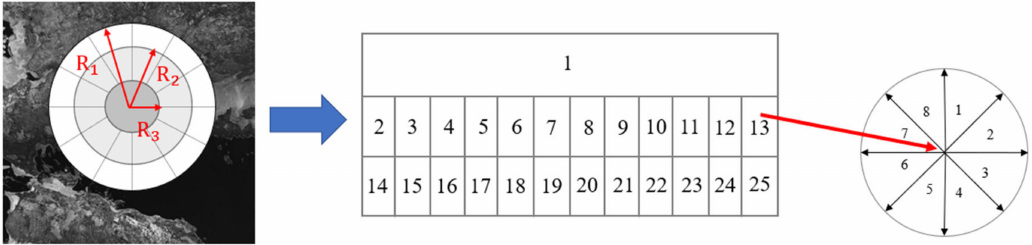
Figure 5. A log-polar descriptor for multimodal image grid